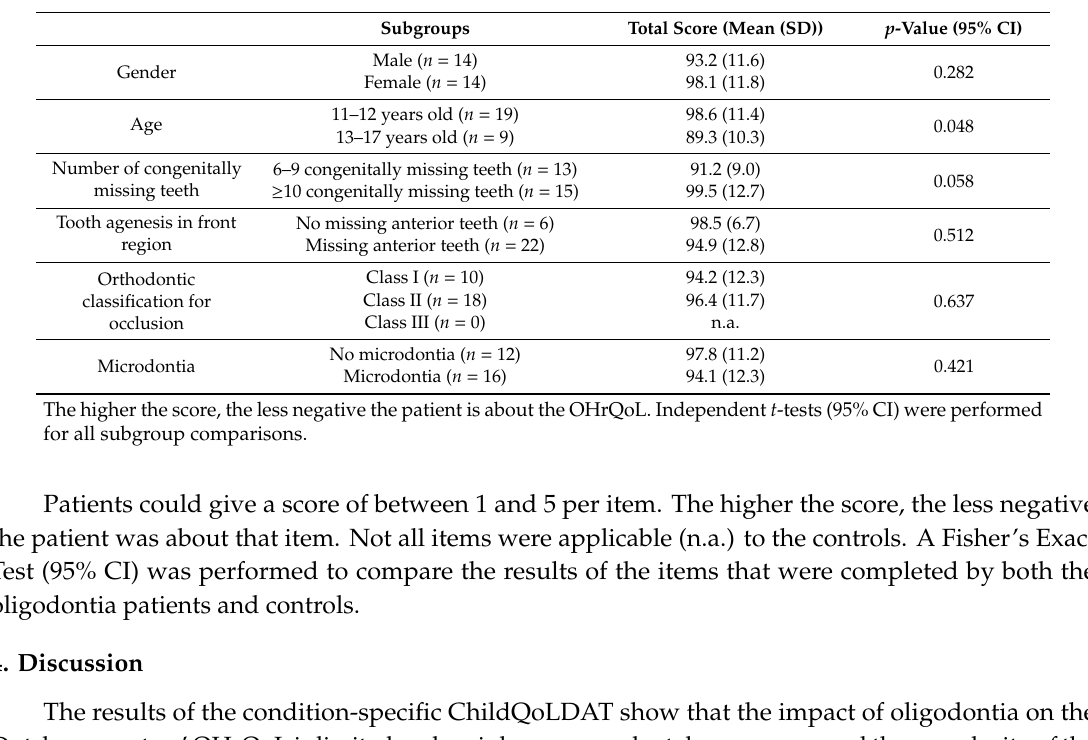
Table 3. Subgroup analyses of the total scores of the oligodontia patients’ included items (range